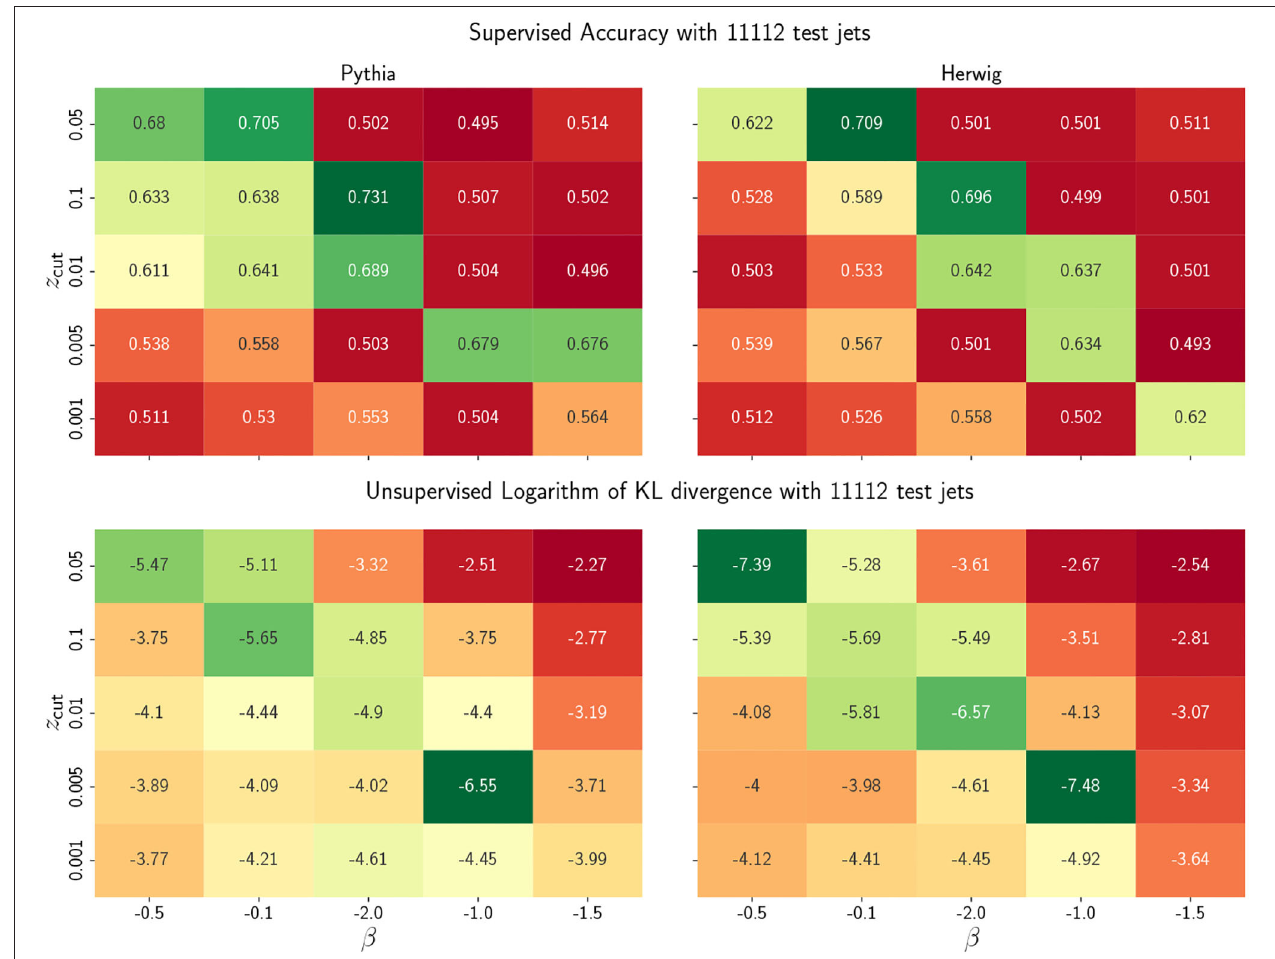
FIGURE 3 | Comparison of supervised and unsupervised learning performance metrics for various hyperparameter choices using the same input data. The color code reflects the goodness of the metrics by coloring in green high accuracies and low KL divergences and vice versa in red. We note that the best hyperparameter choice is consistent with the results reported in Frye et al. (2017). Moreover, since there is a fair agreement of the best regions in the upper (supervised) and lower (unsupervised) panels, this suggests that an unsupervised optimization in real data would select a region of good accuracy. Observe that right and left plots correspond not only to different generators, but also to the different setup of the generator